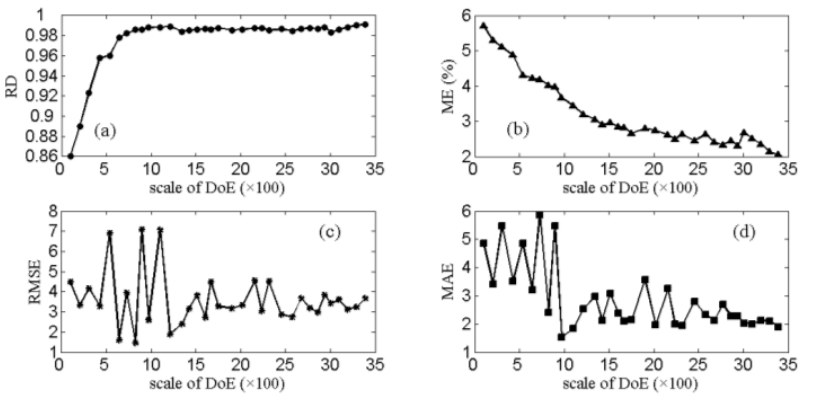
Figure 6. Accuracy/error measures of the kriging model. ( a ) the change of RD; ( b ) the change of ME; ( c ) the change of RMSE; ( d ) the change of MAE.